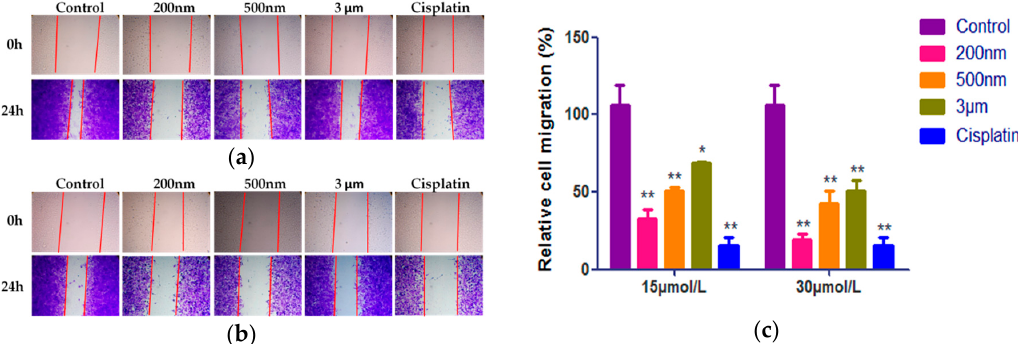
Figure 4. E ff ects of di ff erent sizes and concentrations of QE-NCs on the mobility rate of A549 cells Figure 4. Effects of different sizes and concentrations of QE-NCs on the mobility rate of A549 cells ( n ( n = 3). ( a ) Results of the wound healing assay with treated with 15 µ mol / L QE-NCs. ( b ) Results of the = 3). ( a ) Results of the wound healing assay with treated with 15 μ mol/L QE-NCs. ( b ) Results of the wound healing assay with treated with 30 µ mol / L QE-NCs. ( c ) Statistical analysis results. * p < 0.05, wound healing assay with treated with 30 μ mol/L QE-NCs. ( c ) Statistical analysis results. * p < 0.05, ** p < 0.01, compared with the blank control group. ** p < 0.01, compared with the blank control group. Table 4. The mobility of QE-NCs of di ff erent particle sizes on A549 cells ( n = 3). Table 4. The mobility of QE-NCs of different particle sizes on A549 cells ( n = 3). Concentrations